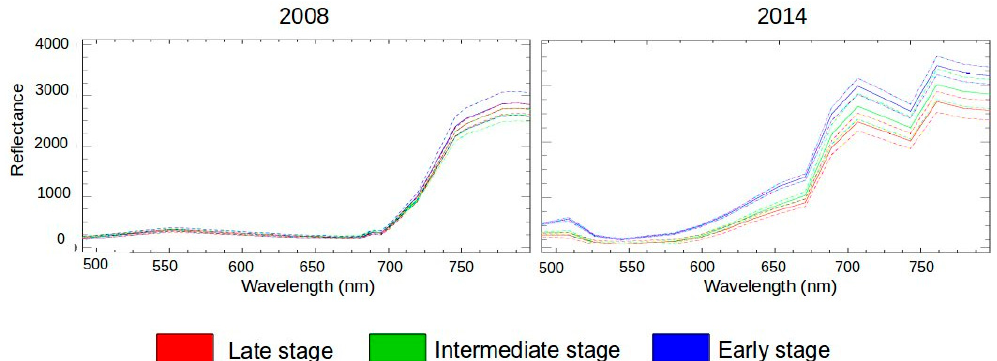
Figure 4. Reflectance signature of the three successional stages of TDF for 2008 and 2014, after inverted PCA. Mean value (solid line) and standard deviation (dashed line).